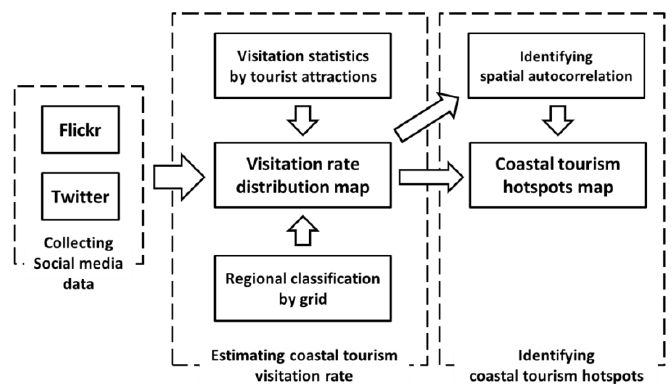
Figure 1. Research Framework.